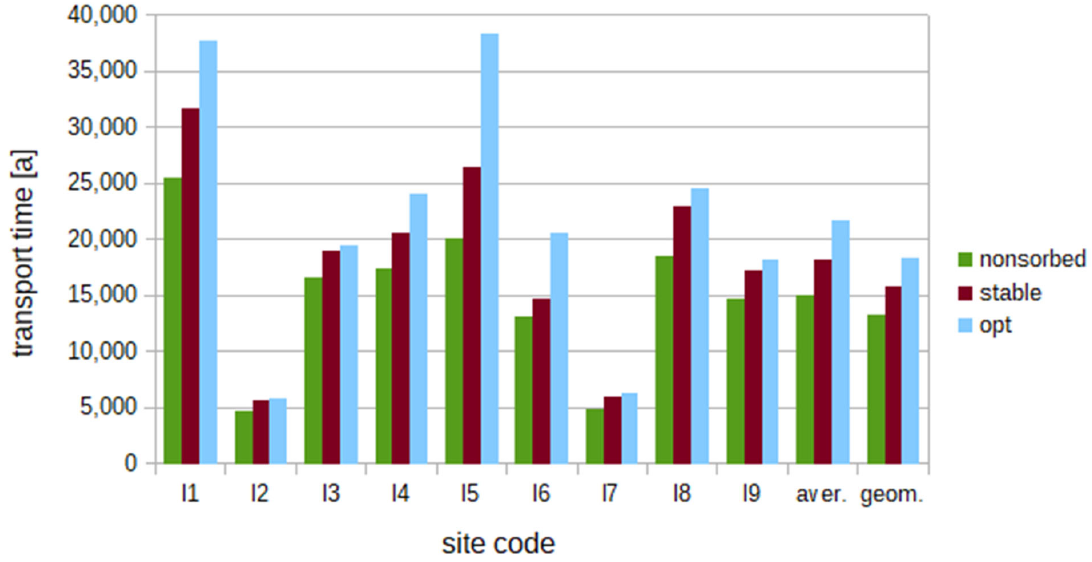
Figure 7. Tracer travel times for test sites for the non-sorbing tracer, the average of stable tracers (“stable”) and for optimized parameters (“opt”); there are also arithmetic (“aver.”) and geometric (“geom.”) averages of all sites. Table 3. Longitudinal dispersivities (m) for test sites postprocessed from the non ‐ sorbing tracer, from the average of the stable tracers (“stable”) and the optimized values. There are also (arithmetic) and geometric averages over all sites.